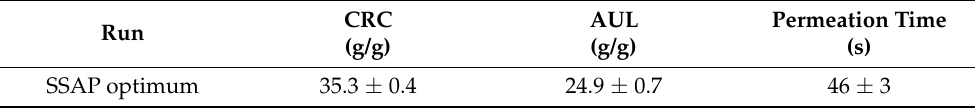
Table 3. Reproducibility experiments under optimal